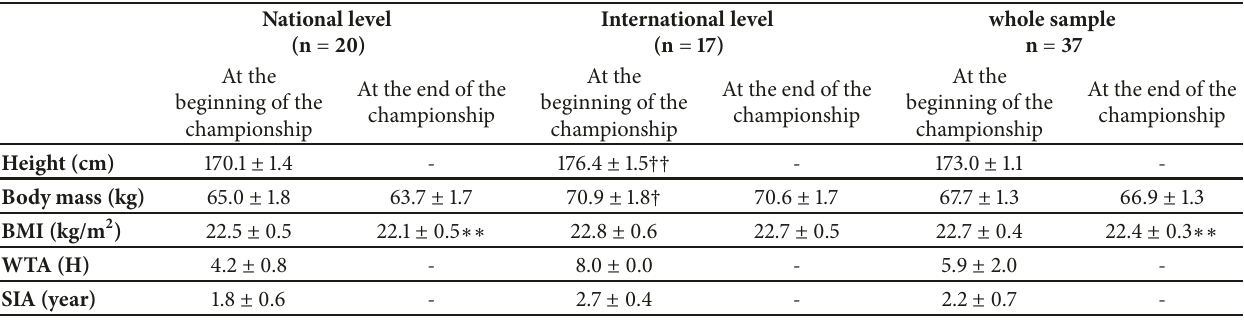
Table 2: Morphological parameters of cardiac left ventricle in a sample of soccer referees at the beginning and the end of the Division 1 championship (Benin, 2016). N ational le v el I nternational le v el ( n = 20) ( n = 17) At the beginning of At the end of the At the beginning of At the end of the the championship championship the championship championship IVS d (mm) 9.9 ± 0.0 10.1 ± 0.0 10.4 ± 0.1 11.0 ± 0.0 LVE DD (mm) 45.8 ± 0.4 45.0 ± 0.4 49.1 ± 0.4 47.3 ± 0.4 LVE DDi (mm/m 2 ) 26.8 ± 0,1 26.6 ± 0.1 27.2 ± 0.1 LVPW d (mm) 8.9 ± 0.0 8.3 ± 0.0 LVM (g) 149.1 ± 7.6 140.1 ± 6.2 170.8 ± 10.6 170.1 ± 9.6 IVSd: thickness of the interventricular septum in diastole; LVEDDi: indexed left ventricular end-diastolic diameter; LVPWd: thickness of the left ventricular posterior wall in diastole; LVM: left ventricular mass; LVMi: indexed left ventricular mass; ∗∗ : difference between beginning and end of the